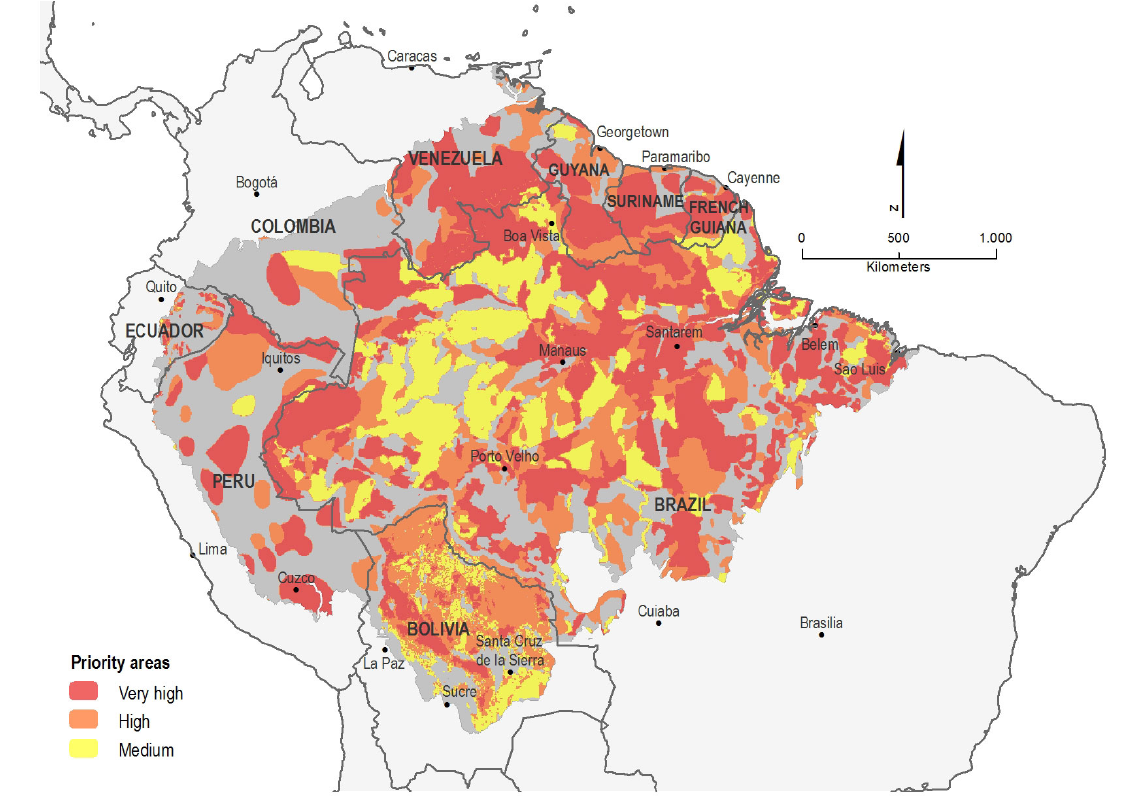
Fig. 3 . Priority areas for biodiversity conservation, based on national and regional assessments. Source: Modified from Neugarten et al.